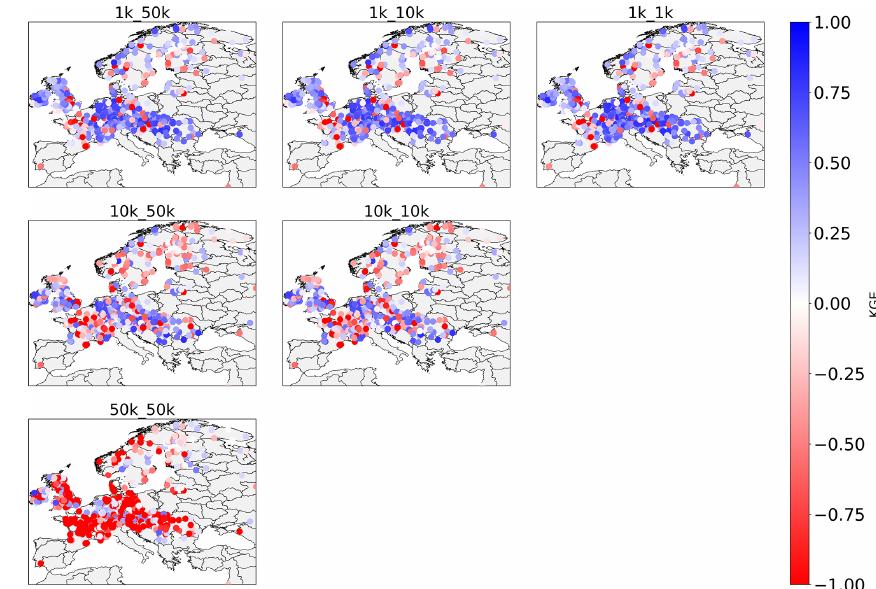
Figure 1. KGE values of all selected GRDC stations in